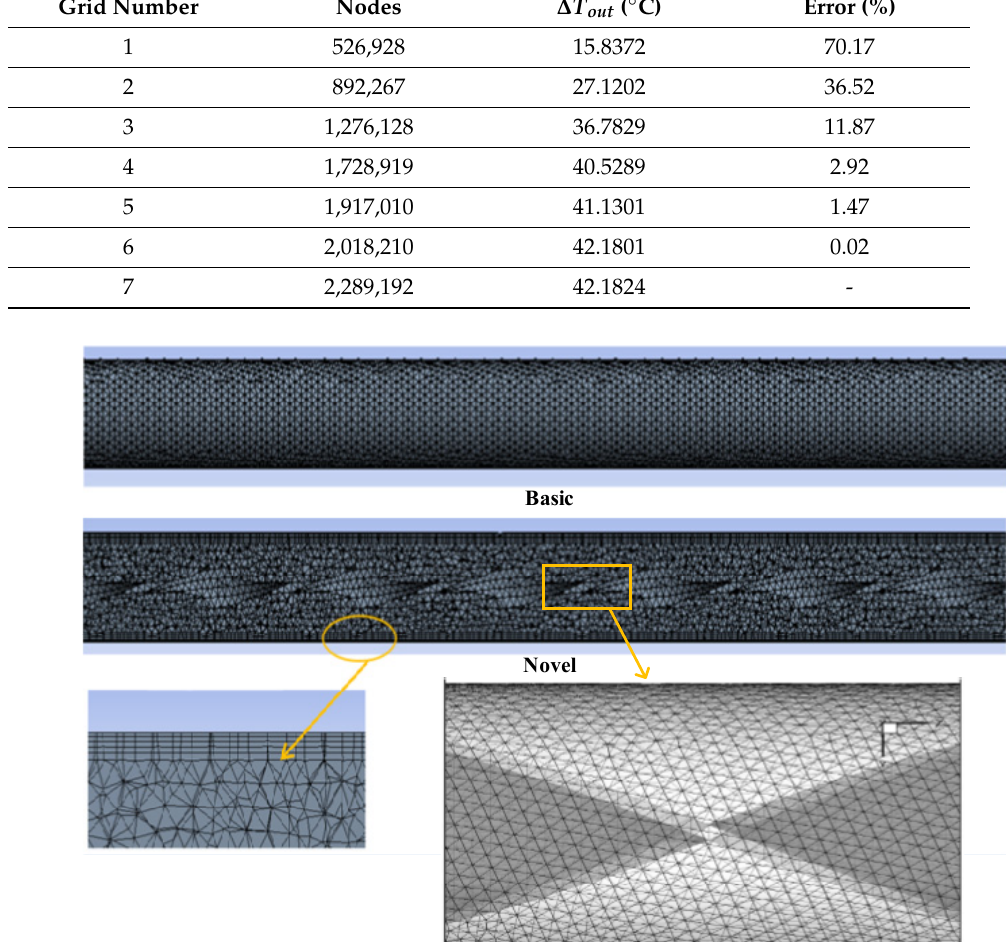
Table 2. Grid independence test in terms of outlet temperature increase in the parabolic trough solar collector using nanofluid at φ = 0.075%, Re = 7400 and the time of 12:30 p.m.